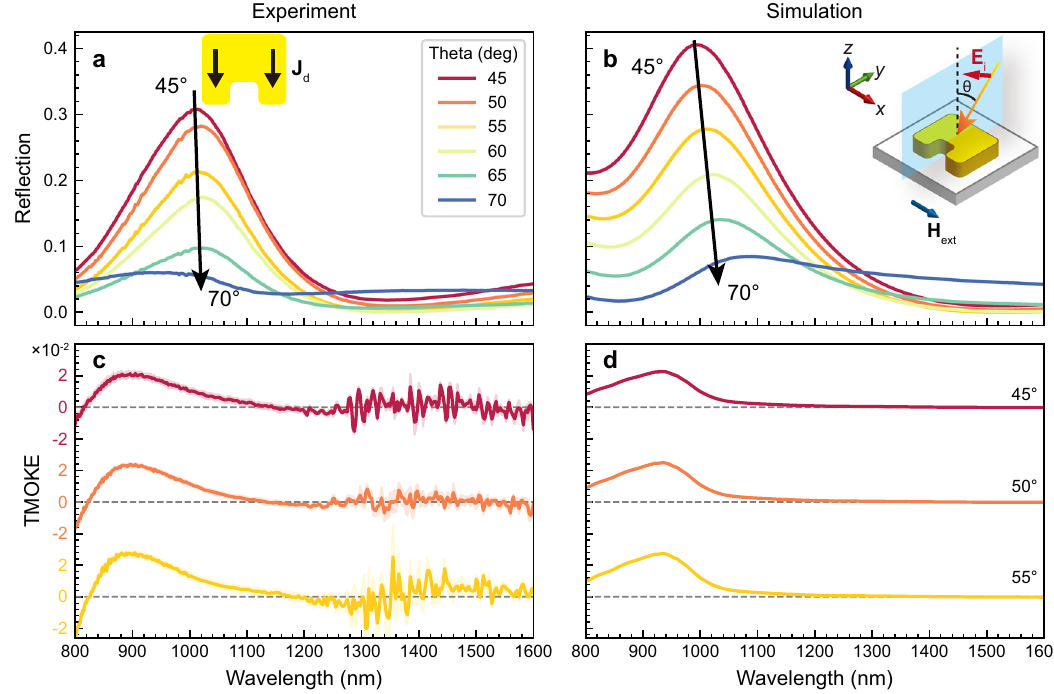
Fig. 4 Re fl ection and TMOKE spectra under p-polarization. a Measured and b simulated re fl ection spectra of the MO-SRR metamaterial and the Ce:YIG thin fi lm for different incident angles under p-polarized incidence. The inset of a shows the displacement current J d directions at resonance wavelength. The inset of b shows the schematic of the incident plane, polarization and direction of applied magnetic fi eld H ext . c Measured and d simulated TMOKE spectra of the MO-SRR metamaterial and the Ce:YIG thin fi lm for different incident angles under p-polarized re fl ection spectra agree well with the experiments, as shown in Fig. 4b. For 45° incidence, the TMOKE reaches 2 × 10 − 2 that is 6.7 times higher than the s-polarized TMOKE, as shown in Fig. 4c. The maximum TMOKE shifts to a shorter wavelength relative to the re fl ection peak, owing to the contributions of the denominator (optical contribution) in Eq. 2. The p-polarized TMOKE of the Ce:YIG fi lm is shown in Supplementary Fig. 6. The larger noise of